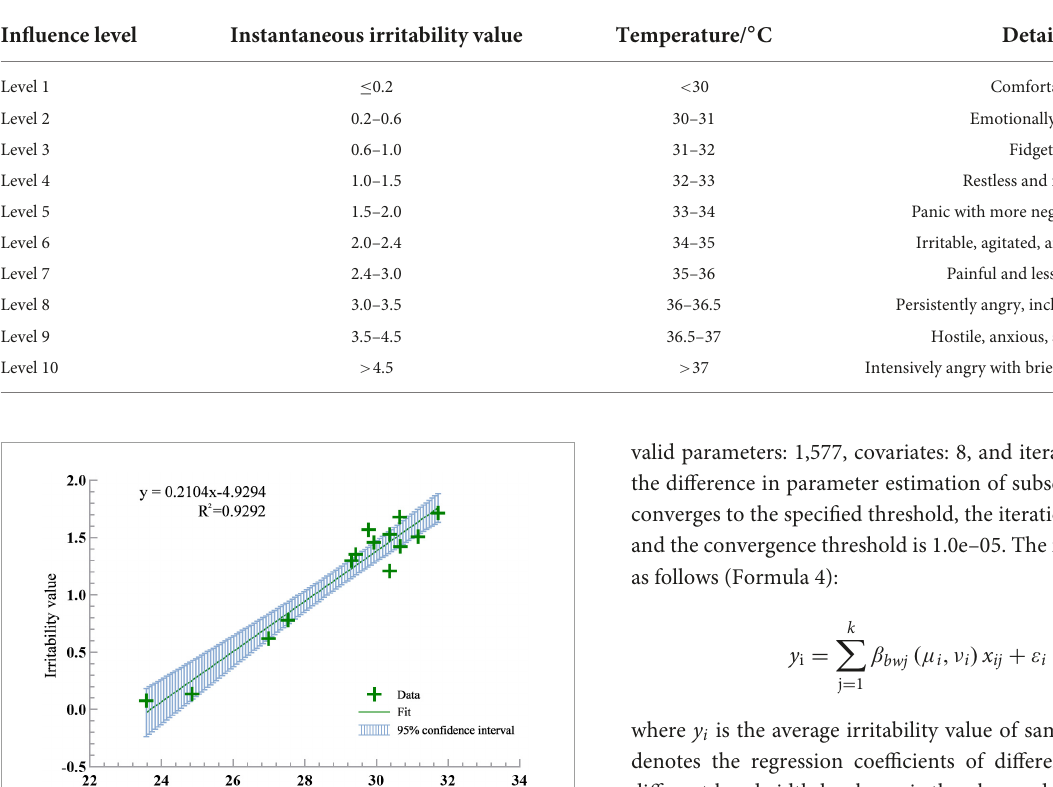
TABLE 2 Standard of evaluating risk of irritability.